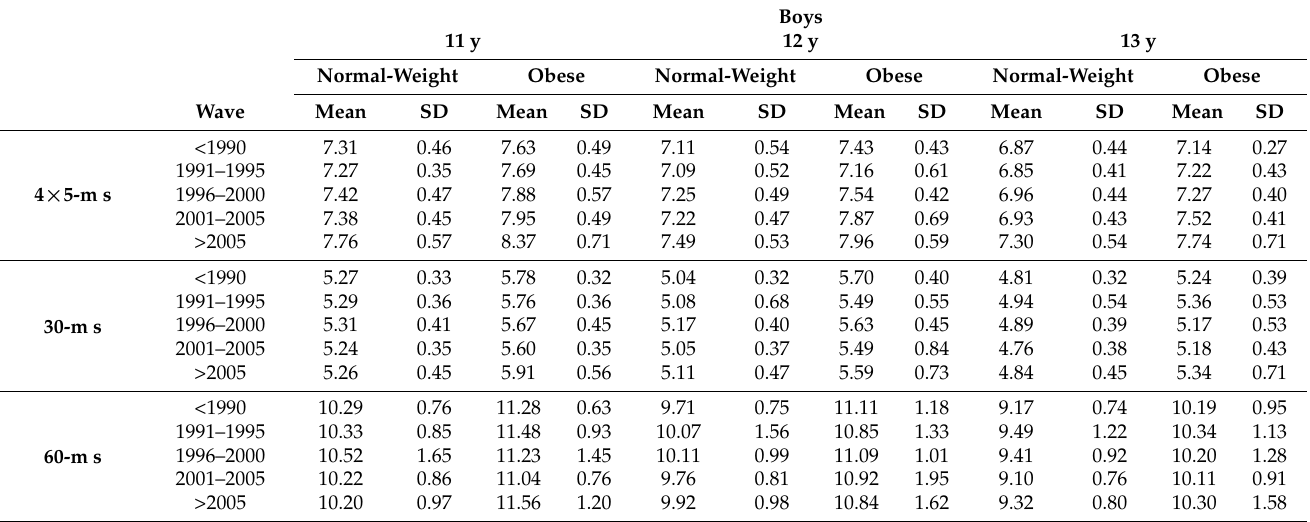
Table 4. Mean physical fitness score by body weight and wave for boys aged 11–13 y ( n =